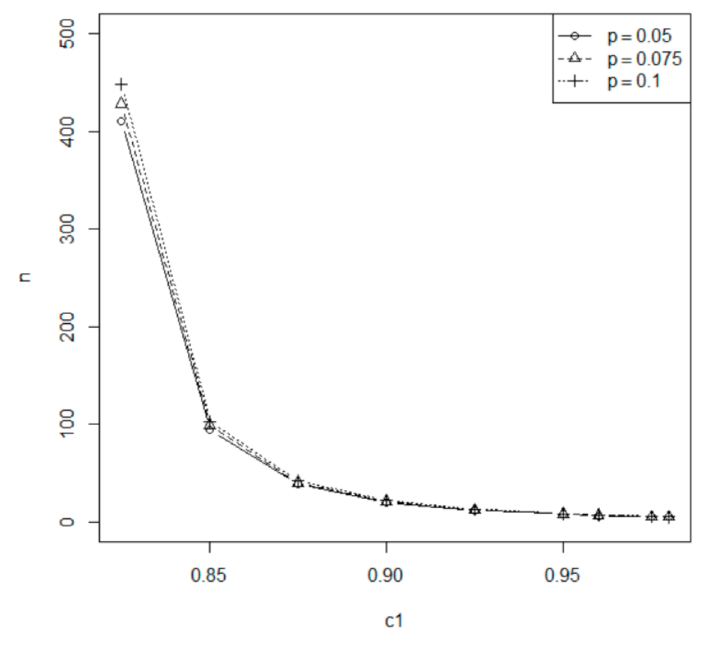
Figure 3. Minimum sample size for the test at α = 0.05, β = 0.2, and m =